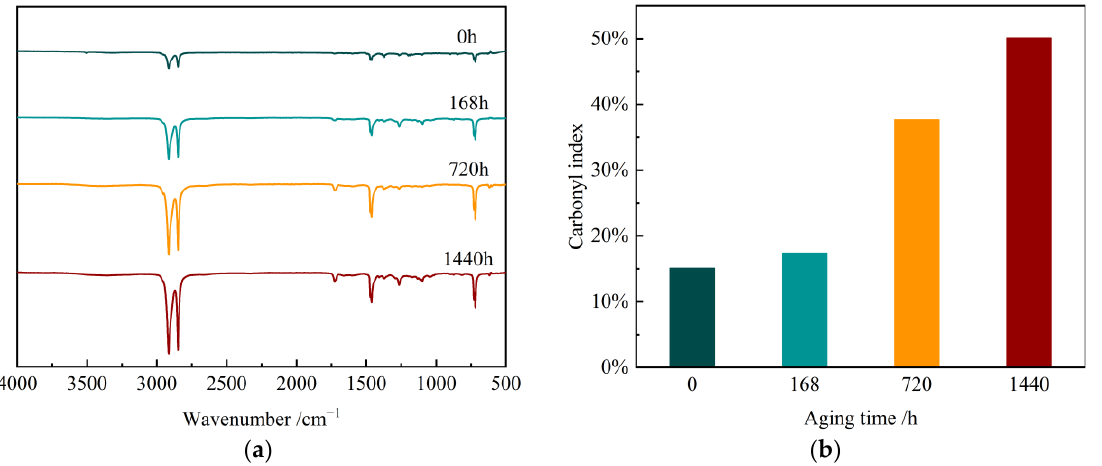
Figure 3. Changes of functional groups of the insulation layer under different aging time. ( a ) Infrared spectrum of insulation layer; ( b ) carbonyl index.